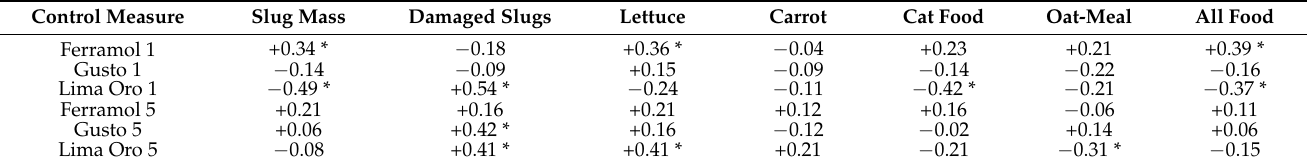
Table 4. Kendall rank correlation coefficients between slug mass, food consumption, and percentage of damaged slugs and the number of bait pellets consumed. The number next to the molluscicide name indicates the number of pellets (one or five) given every two days (a total of three times). Asterisks indicate significant effects: p <